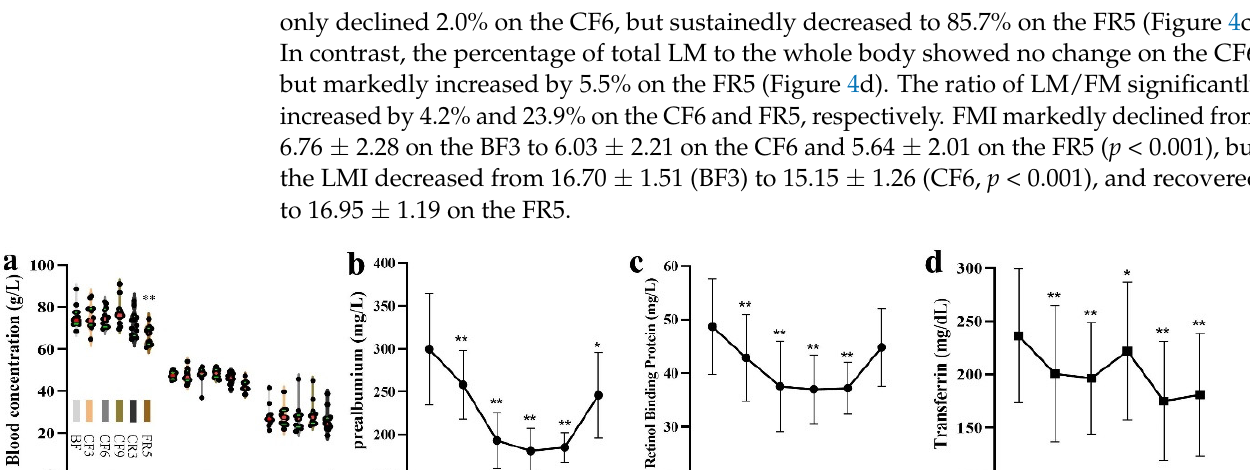
Table 1. The changes of blood routine parameters.